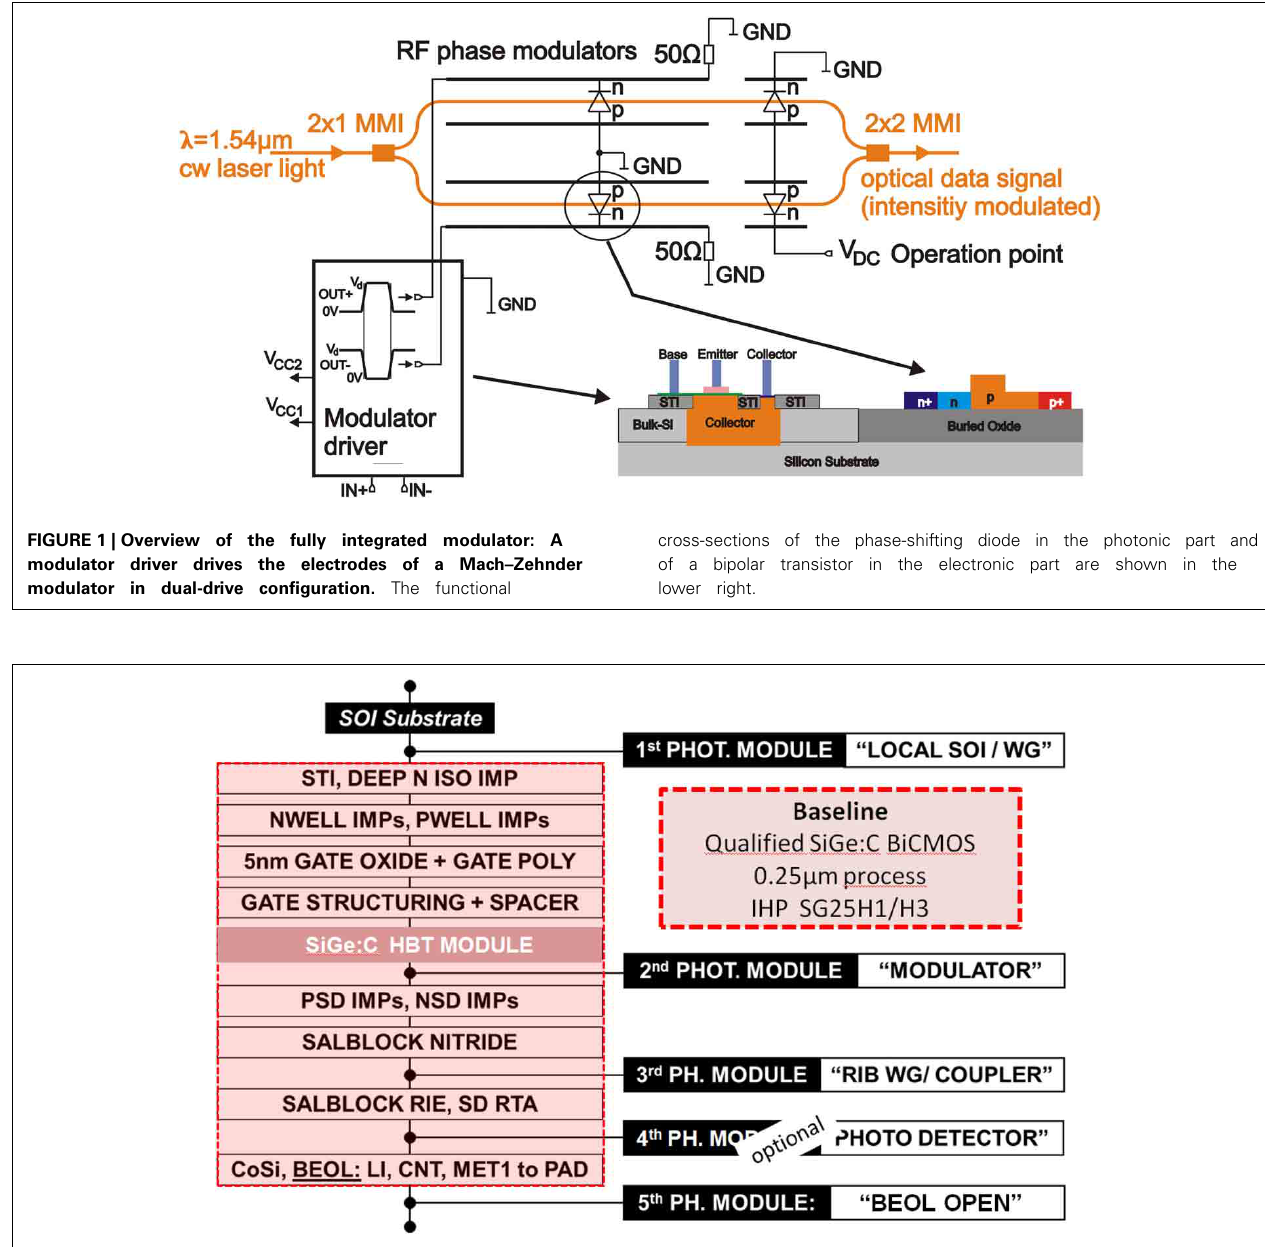
FIGURE 2 | Process